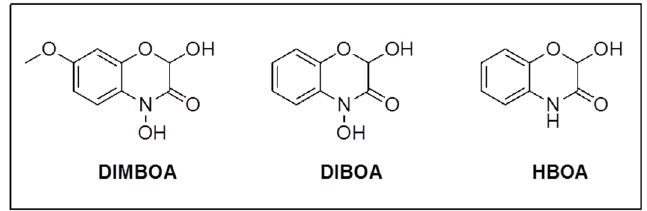
Scheme 6. Allelopathic molecules DIMBOA, DIBOA and HBOA structures.